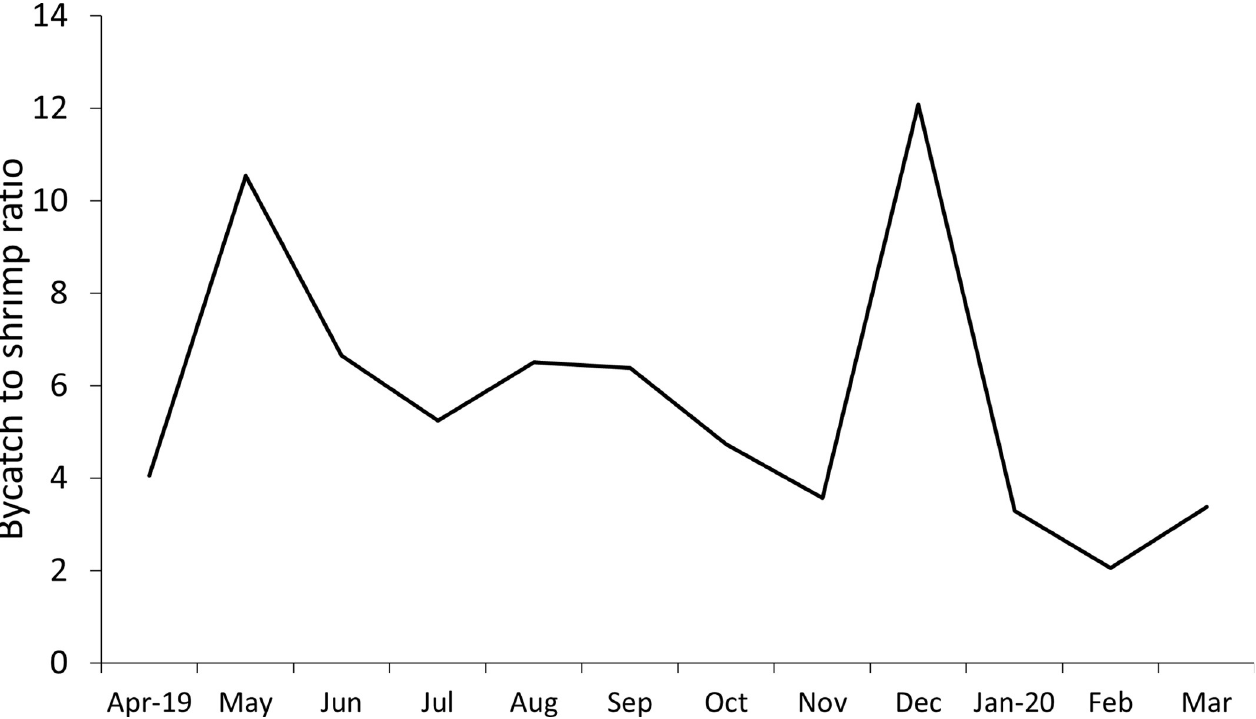
Fig 4. Ratio of aggregated bycatch and target species CPUE in the shrimp trawl fishery operating between Cabo Blanco and Ma´ncora, April 2019-Mar 2020.